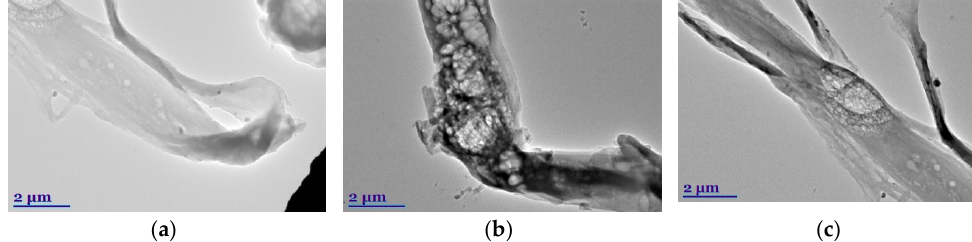
Figure 3. TEM images of CF: ( a ) Microfiber; ( b ) Fibrillated structures; ( c ) Microfiber with different morphology.